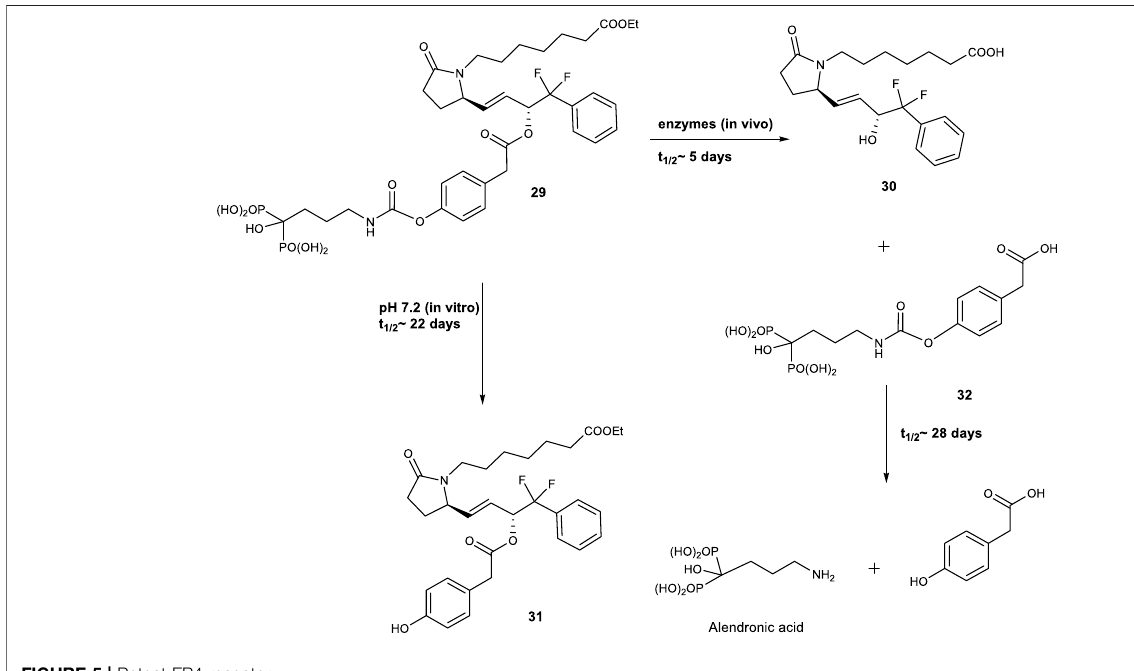
FIGURE 5 | Potent EP4 receptor.